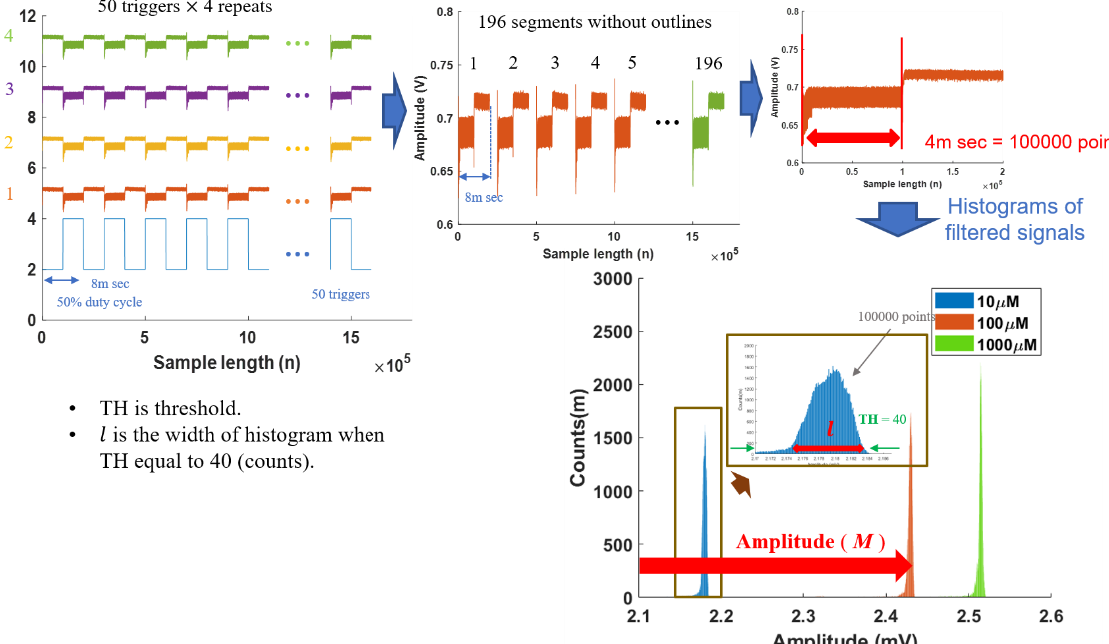
Figure 1. Photoacoustic (PA) signal processing steps to generate histograms.